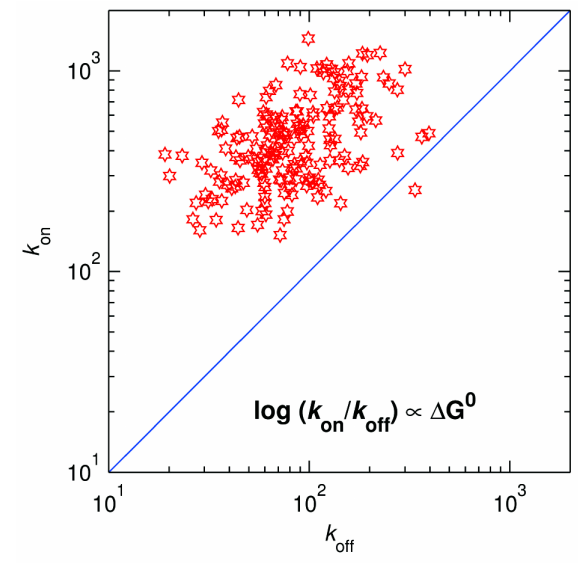
Figure 13. Distribution of k along the diagonal corresponds with zero driving